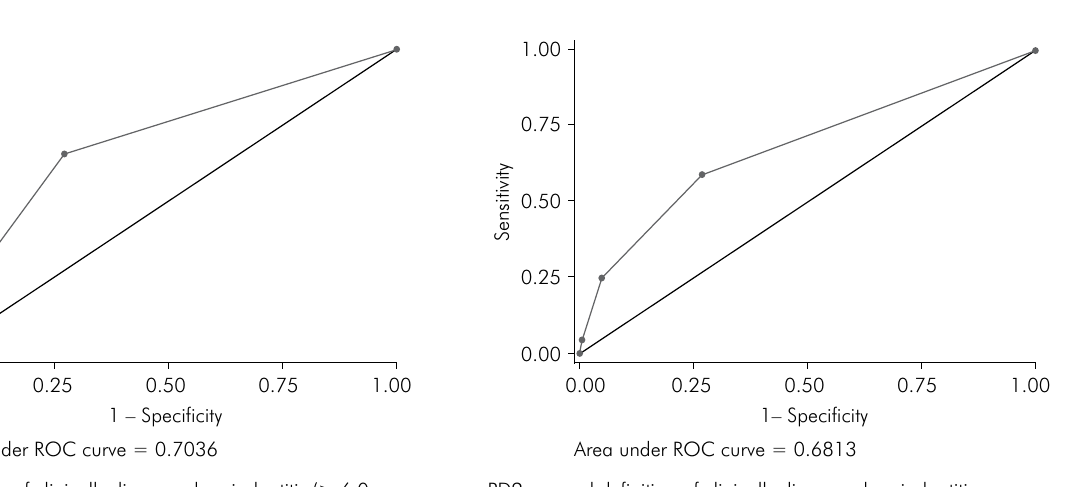
Figure 2. Receiver operating characteristic (ROC) curve for the three unweighted self-reported items on periodontal conditions, considering PD2 as the gold standard.